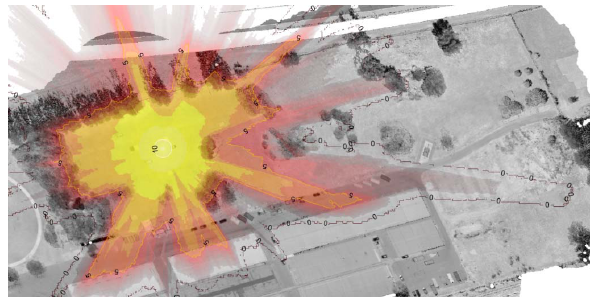
Figure 13. Estimated contamination map, scenario